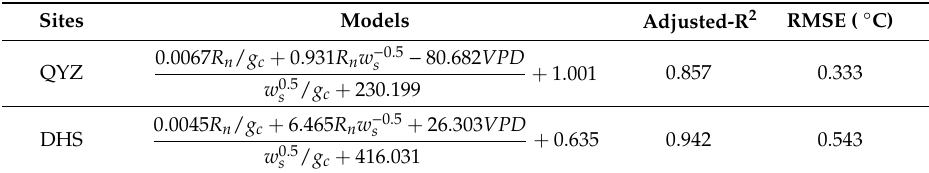
Table 5. Models for assessing canopy-to-air temperature di ff erence ( ∆ T) in the dry season at the QYZ and DHS sites. Sites Models